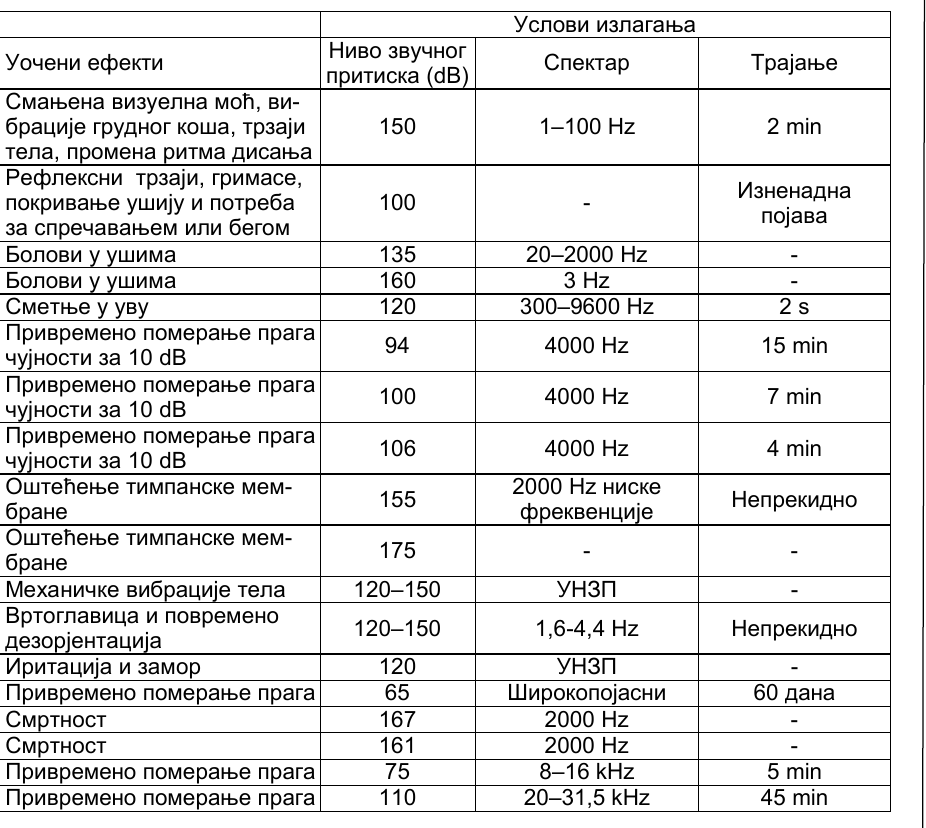
Table 1 – Physiological effects of